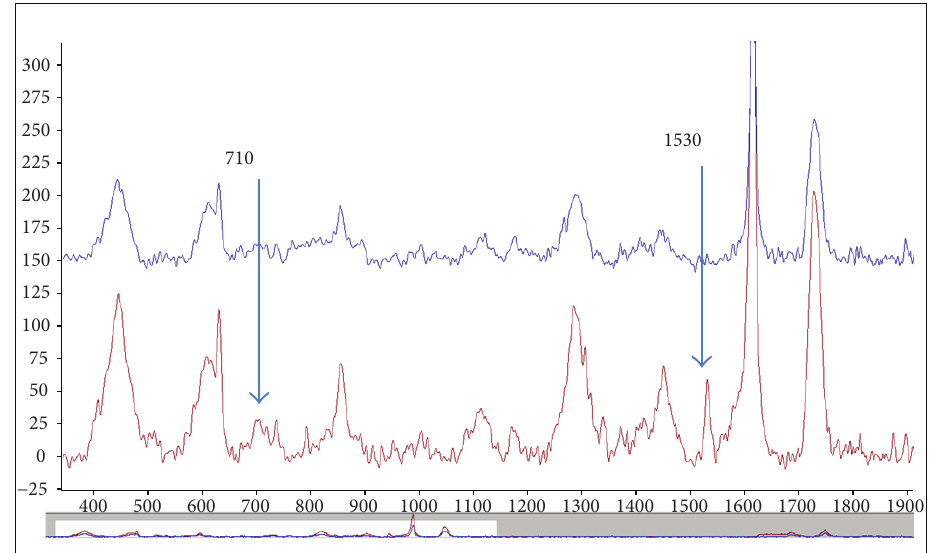
F 7: Micro-Raman analysis parallel to the PET surface indicating the presence of another compound of type “nitrile.”